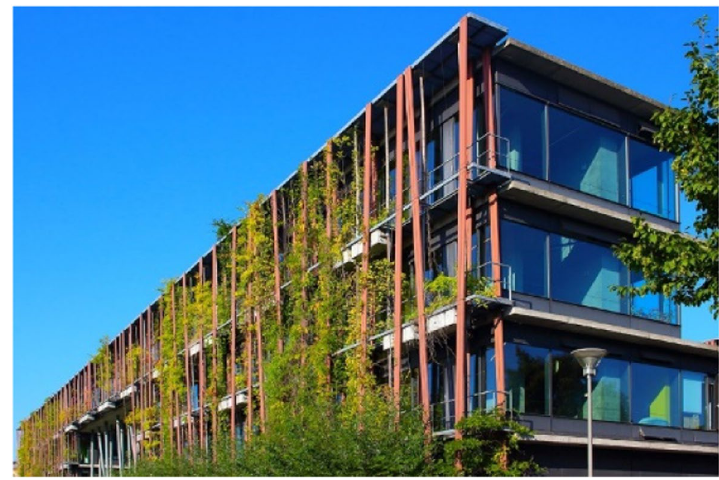
Fig. 3 The facades of the Institute of Physics at Humboldt University, Berlin, Germany [10]. Its facades include rainwater management and energy savings with natural air conditioning through plant walls